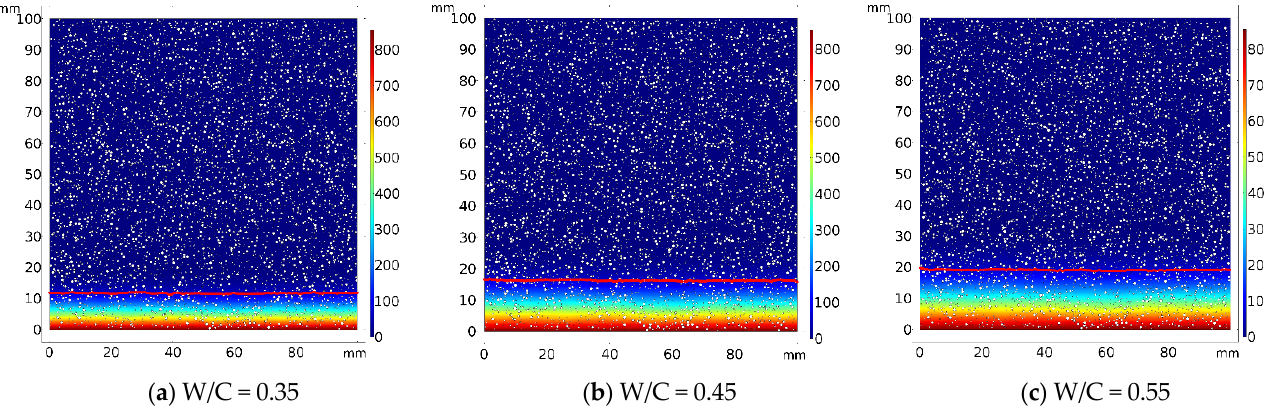
Figure 4. Simulation results of chloride ion diffusion under different w/c ratios and under a hydrostatic pressure of 0.5 MPa.